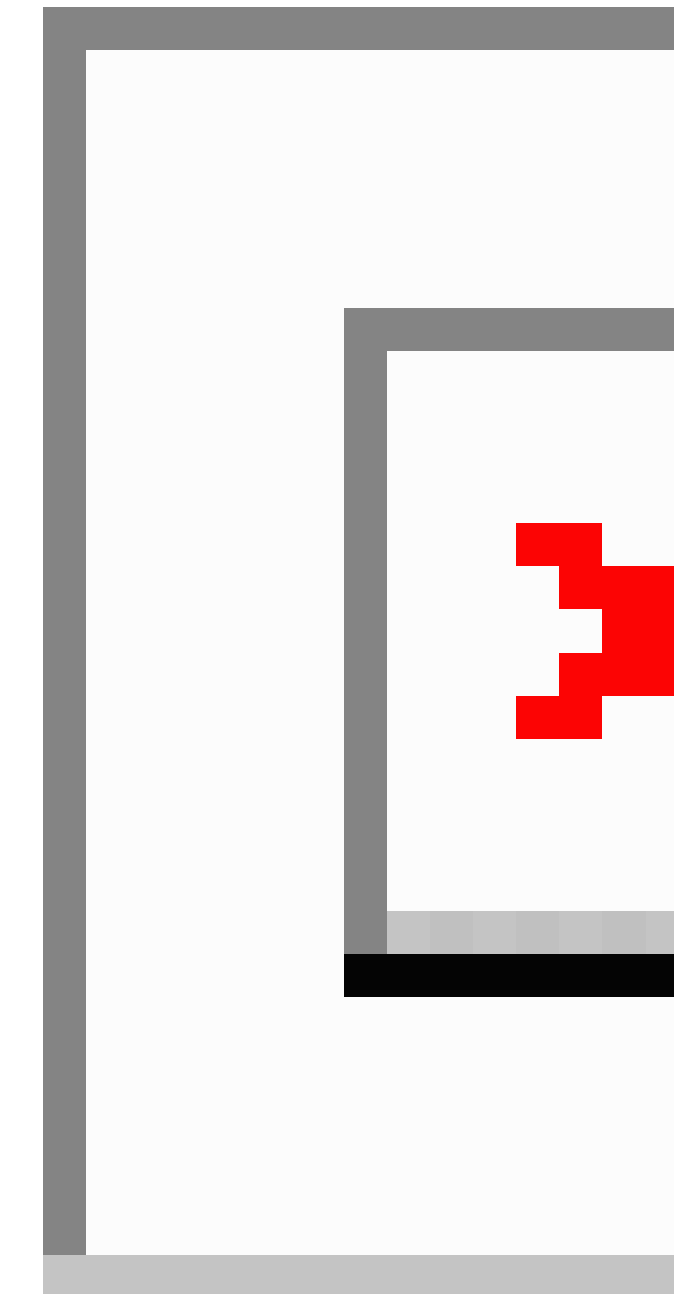
Figure 2. Screenshot of the Vaccine Education Center home